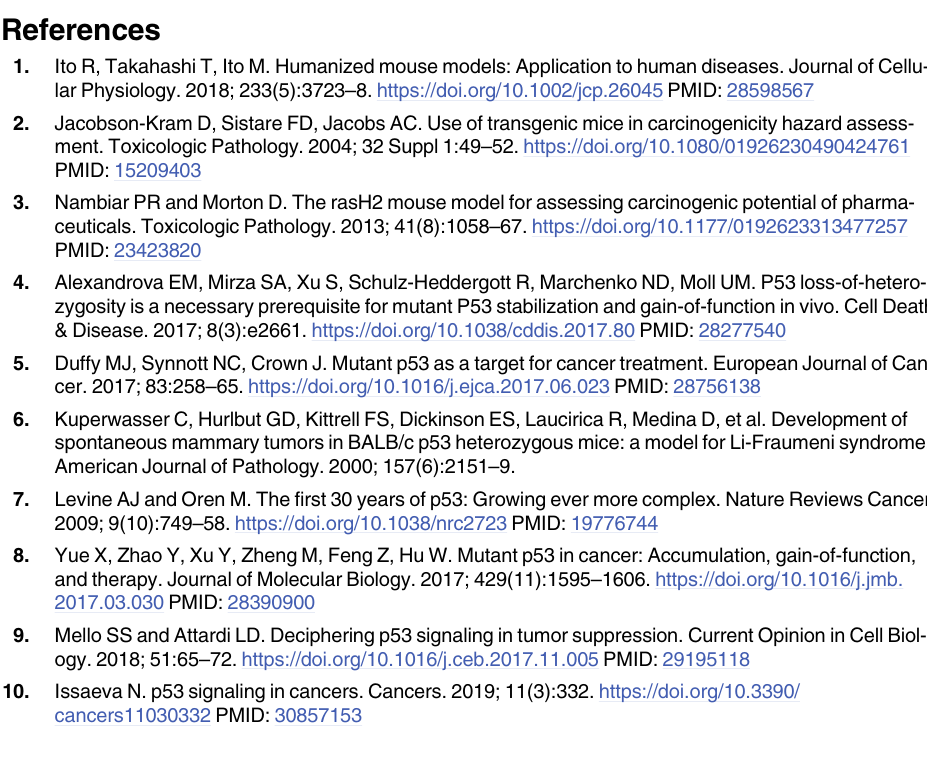
S2 Table. Serum chemistry test results for 25, 50, 75 mg/kg administration